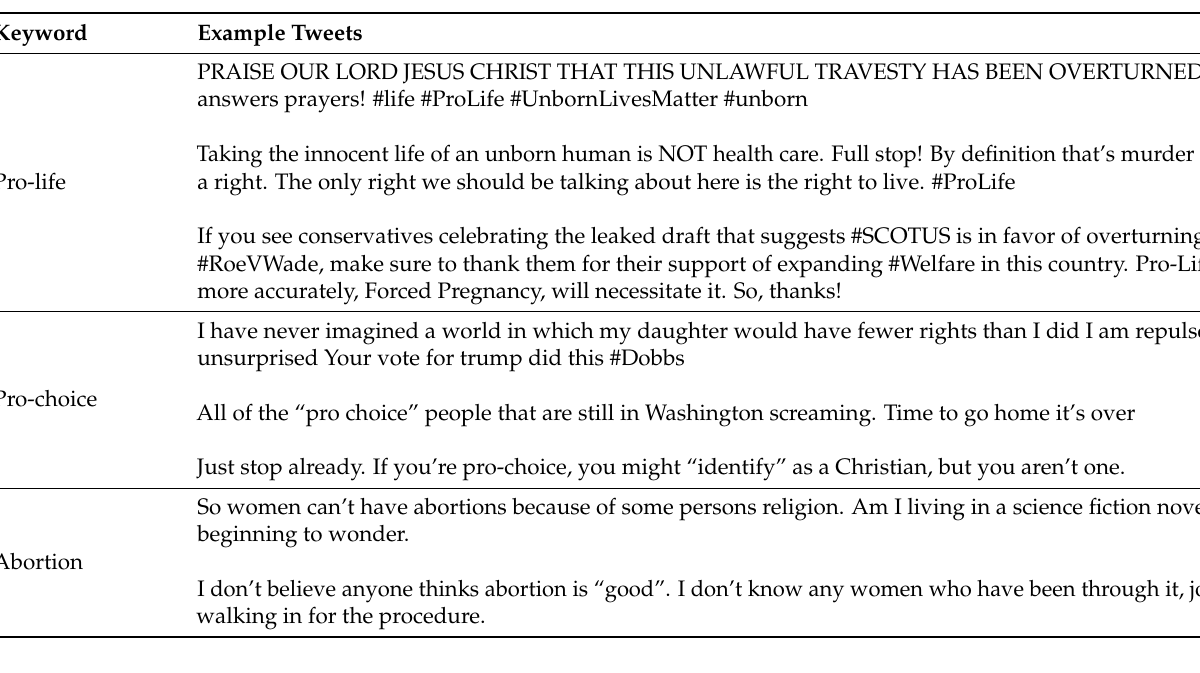
Table 1. Example tweets across topic